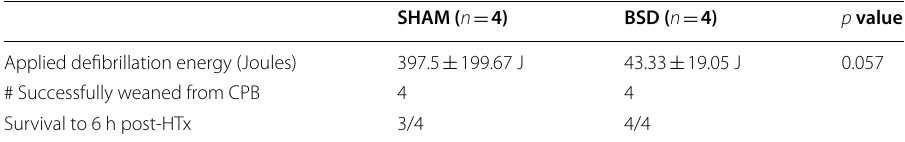
SHAM ( n 4) BSD ( n = 199.67 J 43.33 ±